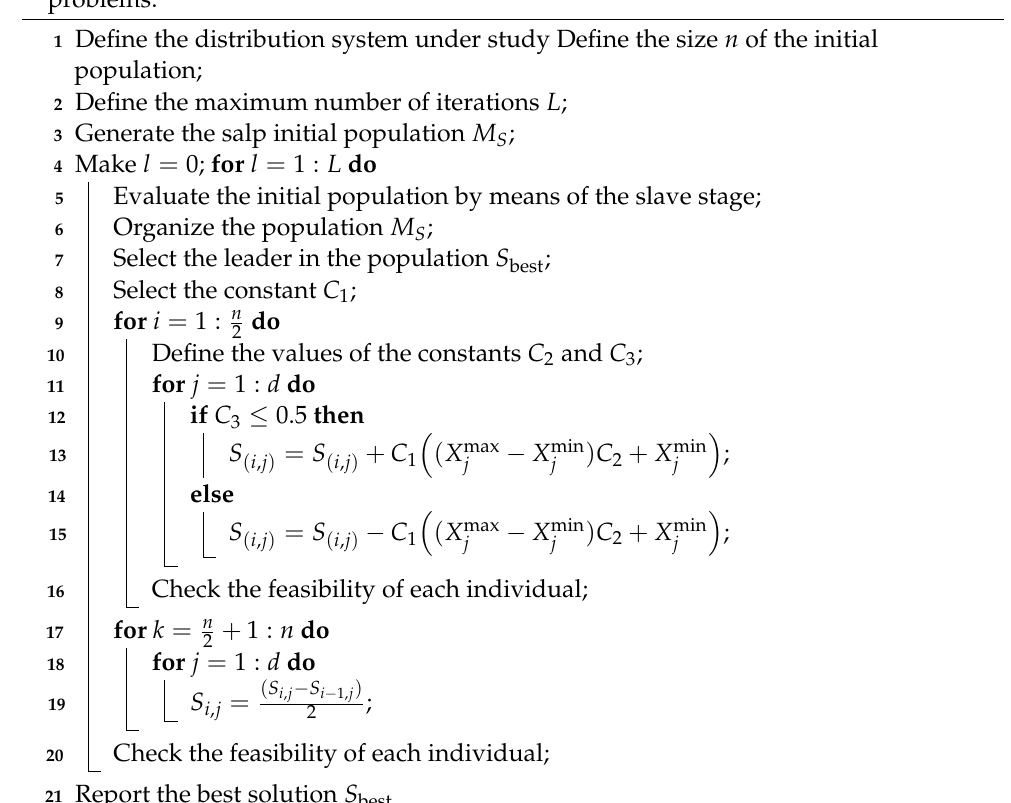
Algorithm 1: General application of the salp swarm algorithm to optimization